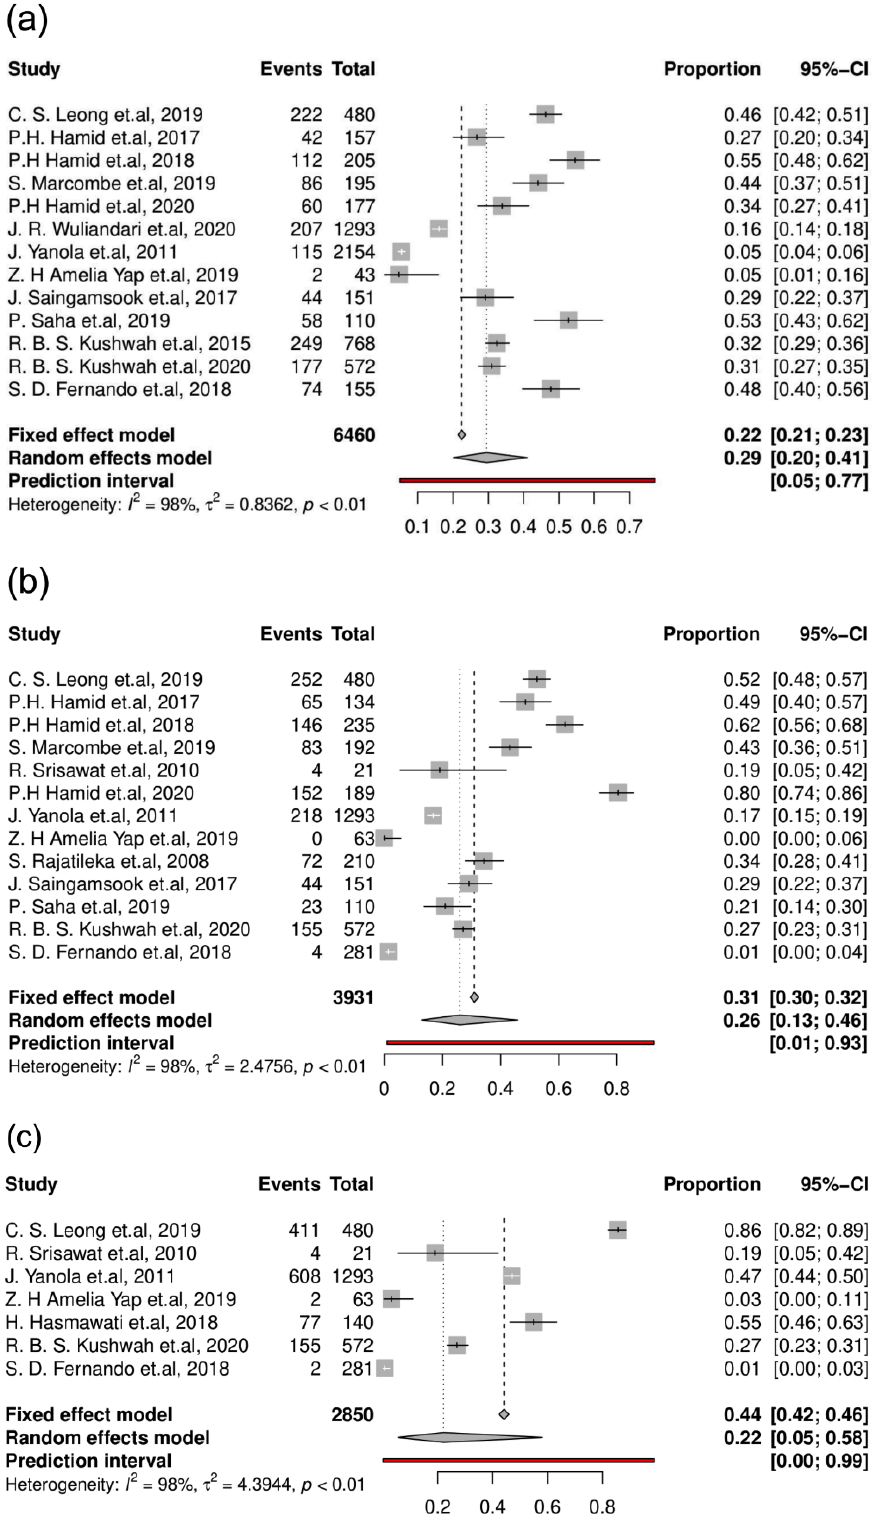
Figure 7. Forest plots of kdr mutations in Ae. Aegypti . ( a ) F1534C; ( b ) V1016G; and ( c ) S989P. Events = the number of insecticide-resistant mosquitoes; total = the total number of mosquitoes